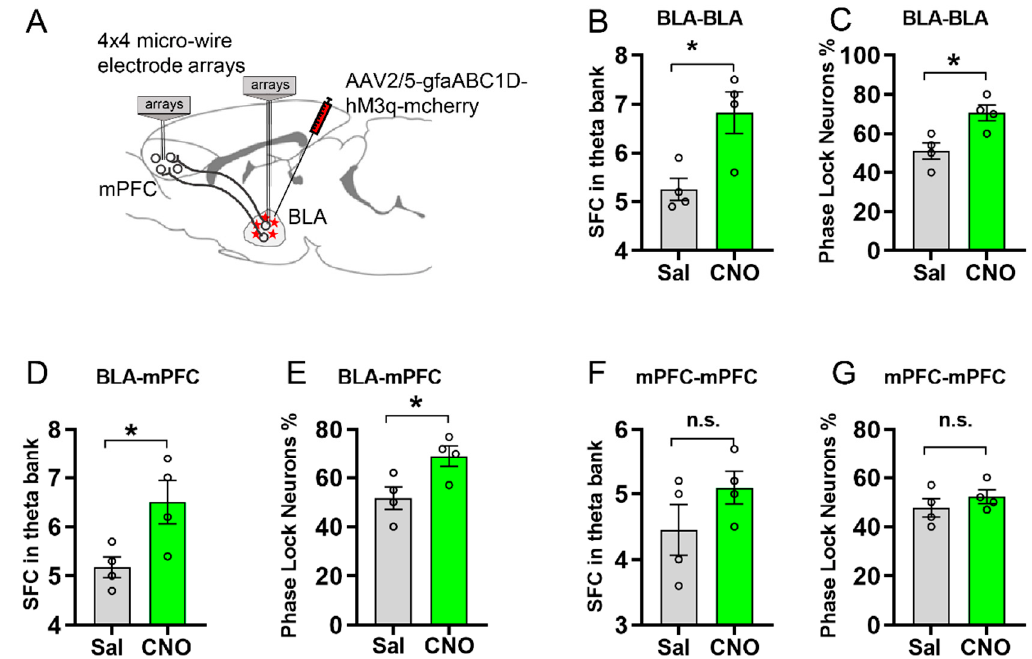
Figure 4. Electrophysiology recording showing that activation of astrocytic Gq in the BLA promotes spike-field coherence and phase locking within the BLA and between the BLA and the mPFC. ( A ) Schematic of the double-recording electrodes implanted in the BLA and the mPFC. ( B , C ) Quantification of spike-field coherence (SFC) within BLA in theta band and phase locking percentage within BLA between CNO and saline treatment ( n = 4 per group, neurons number = 24, p = 0.0165, p = 0.0161, by unpaired Student’s t -test). ( D , E ) SFC between BLA and mPFC in theta band and phase locking percentage between BLA and mPFC with CNO treatment was increased compared with saline group ( n = 4 per group, neurons number = 24, p = 0.0360, p = 0.0336, by unpaired Student’s t -test). ( F , G ) CNO application had no significant effect on SFC and phase locking neuron percentage within mPFC ( n = 4 per group, neurons number = 24, p = 0.2066, p = 0.3688, by unpaired Student’s t -test). * stands for p < 0.05, n.s. stands for no significance All data are presented as mean ±